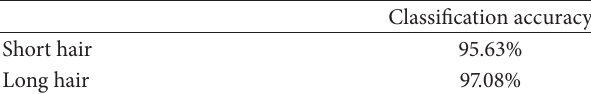
Table 3: Hair style classification accuracy.